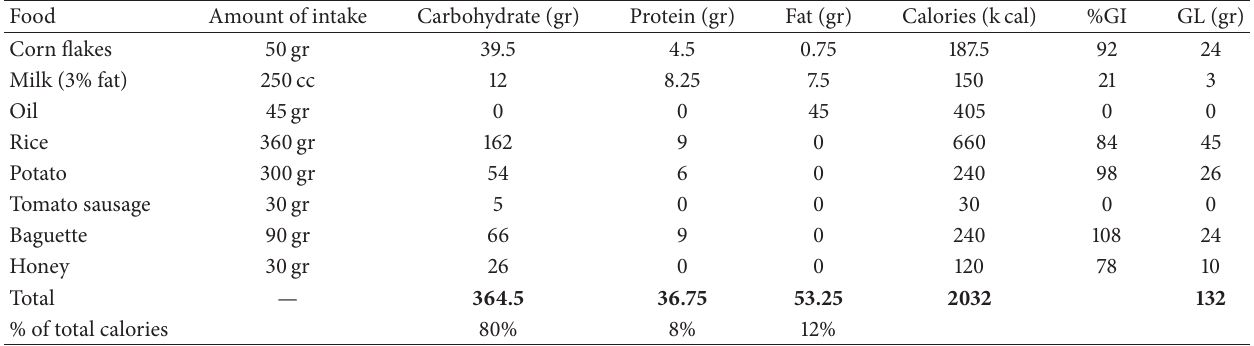
Table 2: Details and ingredients of consumed foods in 24-hour HGI